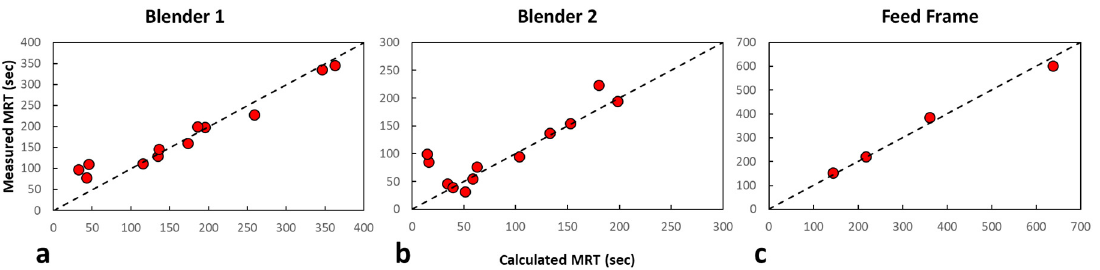
Figure 8. Parity plots for each blending unit comparing the different methods of determining the mean residence time. ( a ) Blender 1 parity plot of the calculated versus measured mean residence time. ( b ) Blender 2 parity plot of the calculated versus measured mean residence time. ( c ) Feed frame parity plot of the calculated versus measured mean residence time.